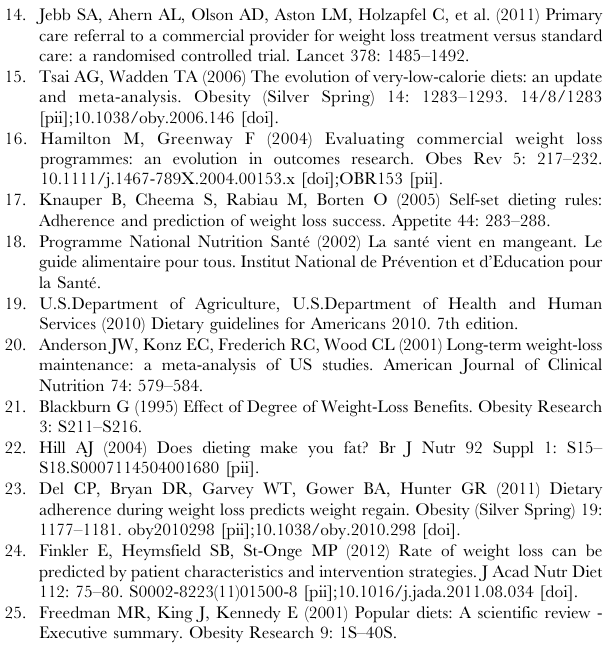
Figure S1 Flow-chart of inclusions in the study. Table S1 Detailed information on the type of diet followed.